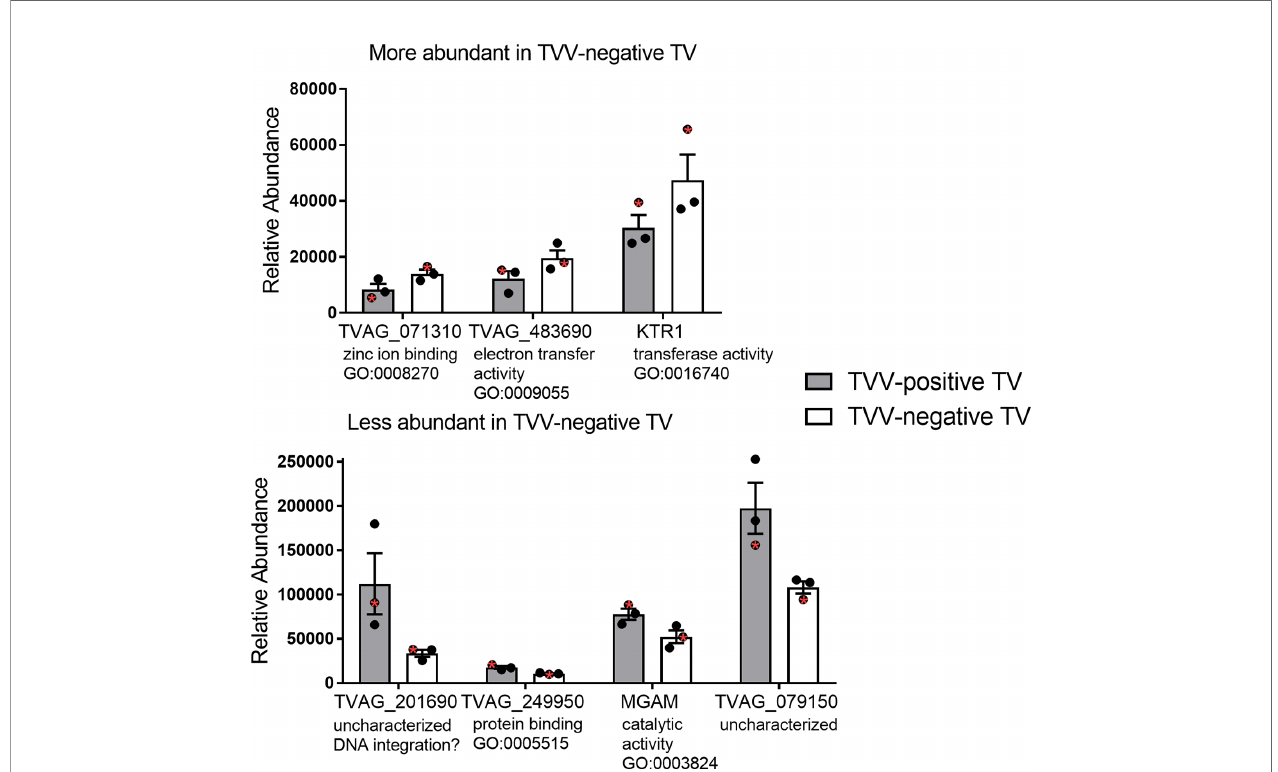
FIGURE 7 | Relative abundance of the differentially expressed sEV proteins. Differential expression analysis compared log2-transformed abundance values of all sEV proteins identi fi ed between virus-negative TV vs. virus-positive TV. Graphs represent relative abundance values of the 7 signi fi cantly differentially expressed (p < 0.05) proteins between three virus-negative TV strains vs. three virus-positive TV strains and plotted as mean ± standard error of mean. The isogenic strains 347V+ and 347V- are noted with a red asterisk within each phenotype. For each protein, gene ontology (GO) terms for molecular function are